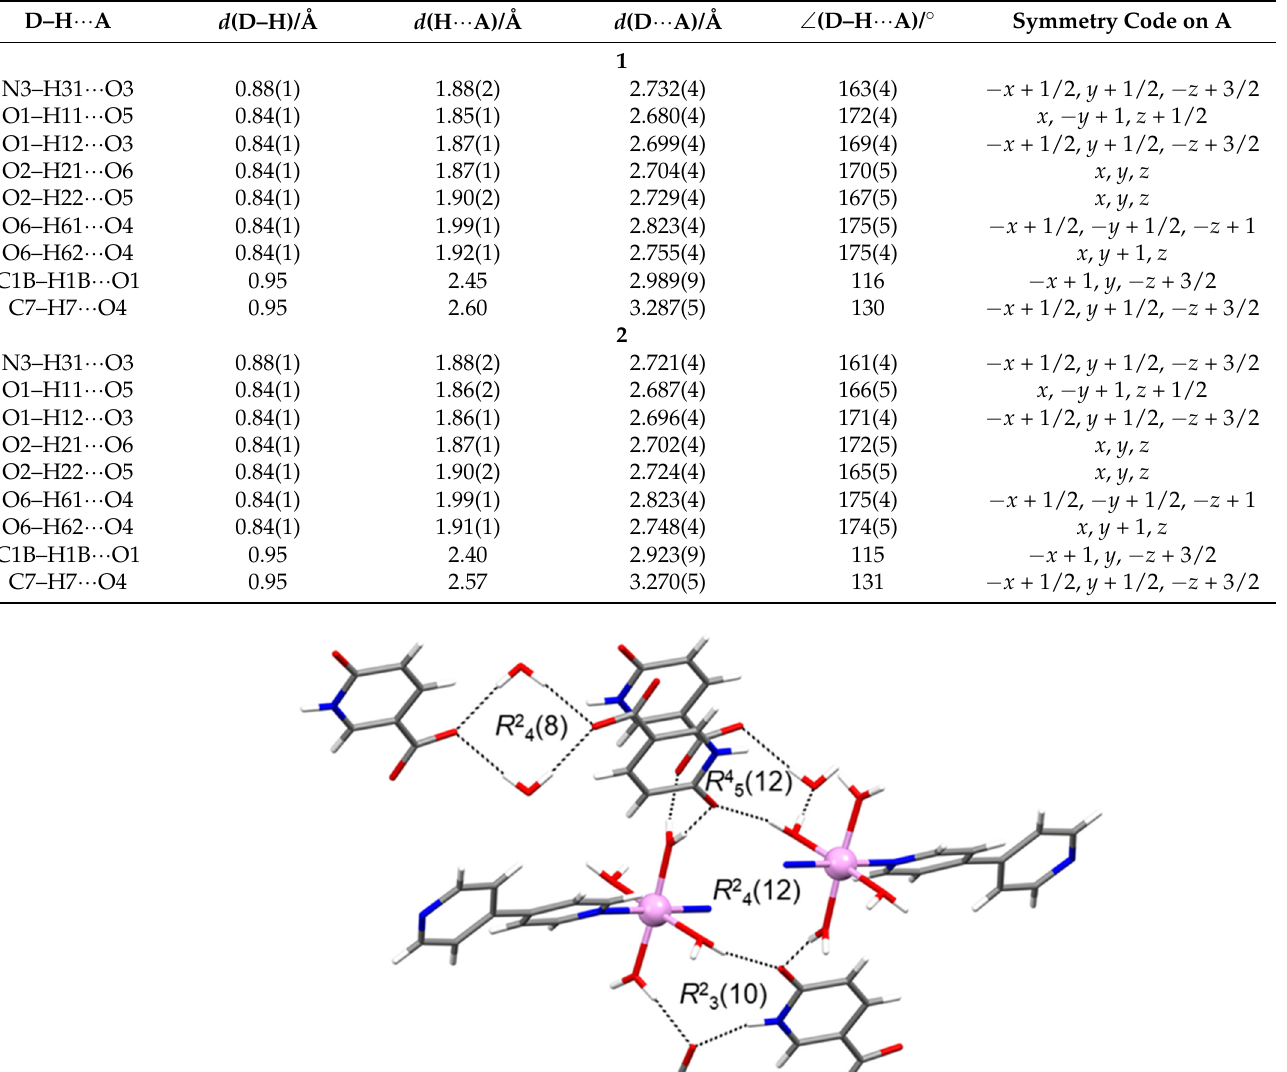
Table 2. The hydrogen bond geometry for {[Co(4,4 (cid:48) -bpy)(H 2 O) 4 ](6-Onic) 2 · 2H 2 O} n ( 1 ) and {[Ni(4,4 (cid:48) -bpy)(H 2 O) 4 ](6- Onic) 2 · 2H 2 O} n ( 2 ).